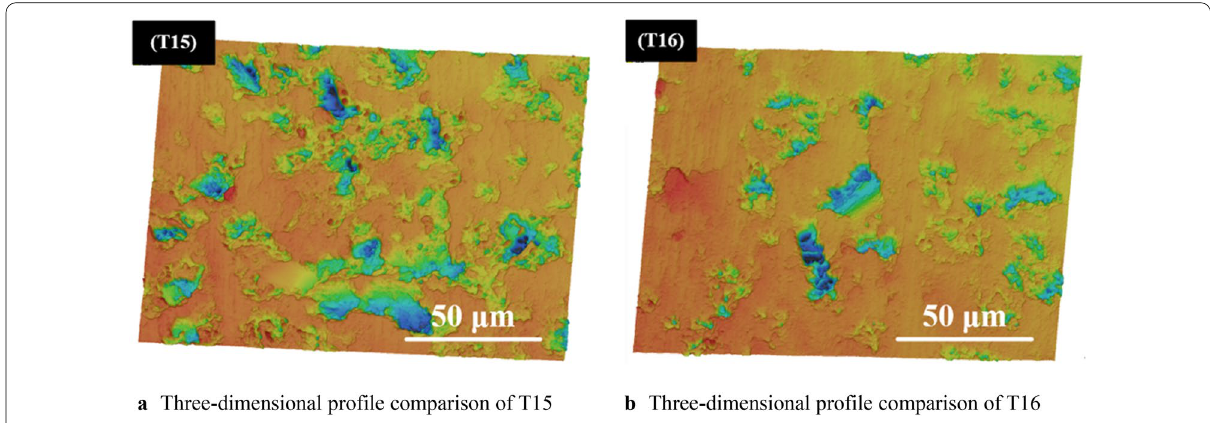
Figure 7 Three-dimensional profile comparison of T15 and T16